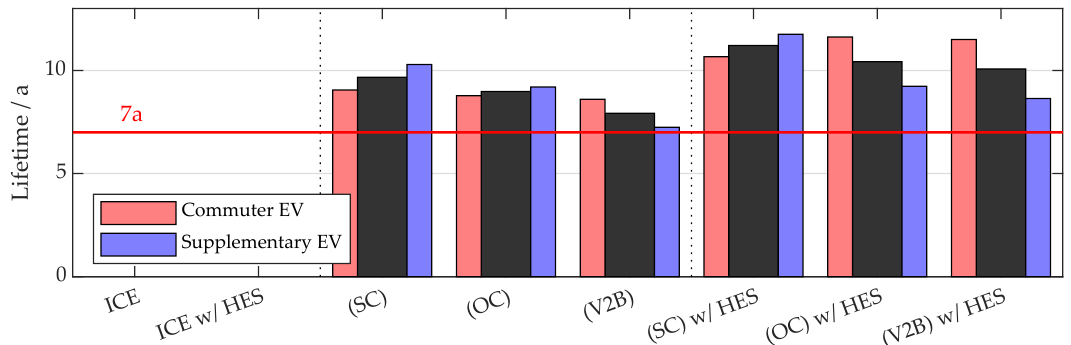
Figure 11. Lifetime calculation of the electric vehicle’s nickel manganese cobalt (NMC) battery, based on a generic battery model, with the defined end of life (EOL) condition of 80% of the nominal capacity. The dark-grey column represents the average value.